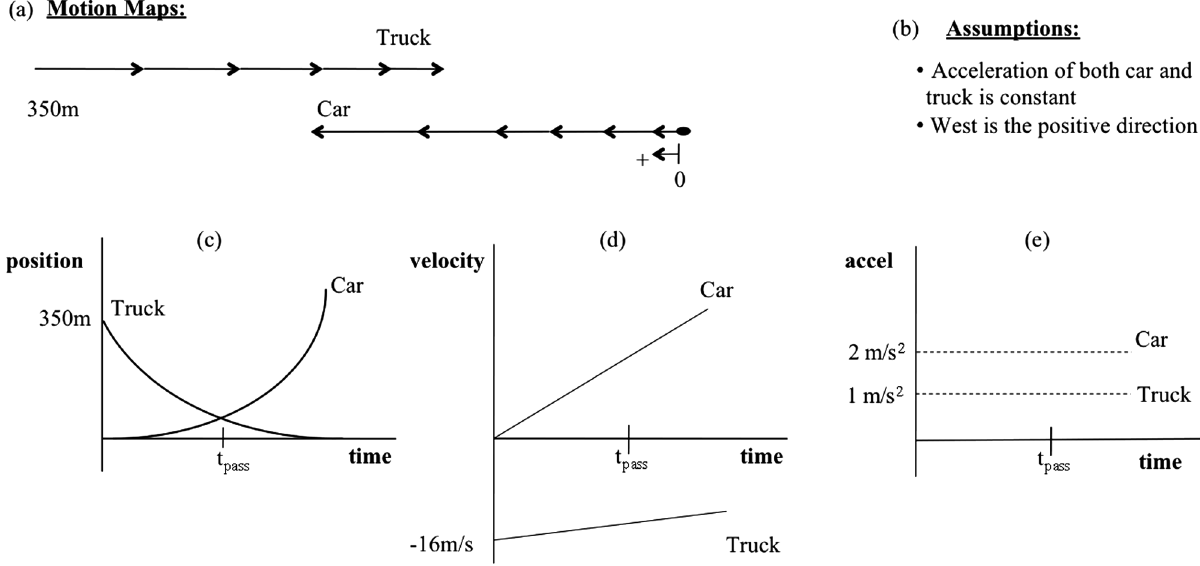
FIG. 2. An example of an acceptable solution to the problem-solving session scenario for students at this point in the semester. (a) Represents motion maps for the car and truck with a defined frame of reference, (b) lists the important assumptions, (c)–(e) depict a coherent set of position-time, velocity-time, and acceleration-time